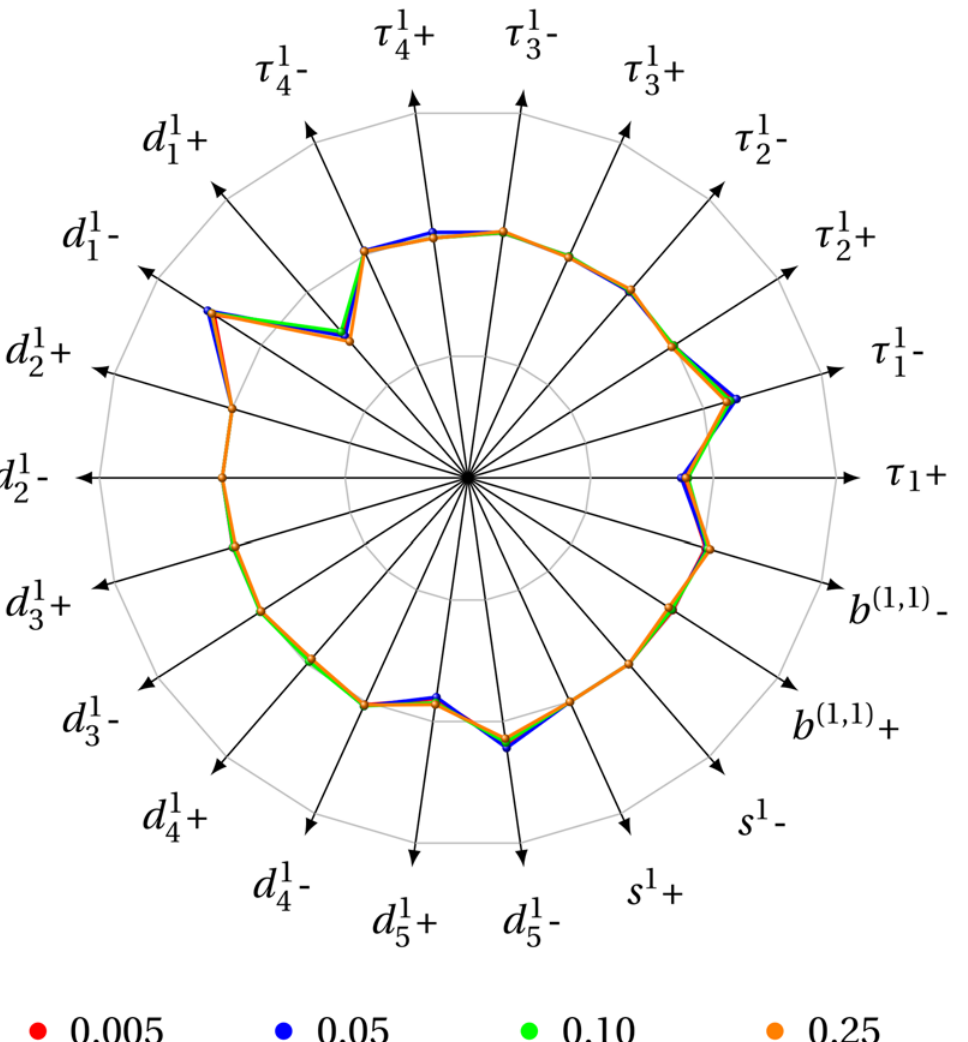
Fig 3. Elasticity analysis. An elasticity analysis of the reversal times, with a deviation of 1% from the corresponding values, for all the 4 costs displayed in Fig 2. The outer, intermediate, and inner circles indicate variations of 1%, 0% and -1%, respectively. The elasticities of each parameter are nearly invariant for the different costs investigated, which suggests that, as far as stability to small perturbations in the model parameters is concerned, the behaviour is uniform in cost.